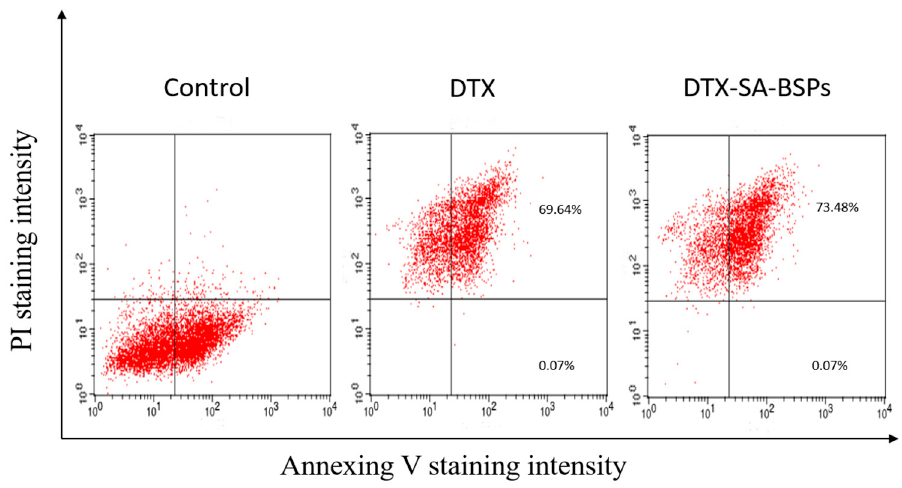
Figure 6. Measurement of cell apoptosis by Annexin V-FITC/PI staining assay. HepG2 cells were treated with 1 mL of 0.5 μ g/mL DTX (docetaxel injection) or DTX-SA-BSPs copolymer micelles for 48 h.